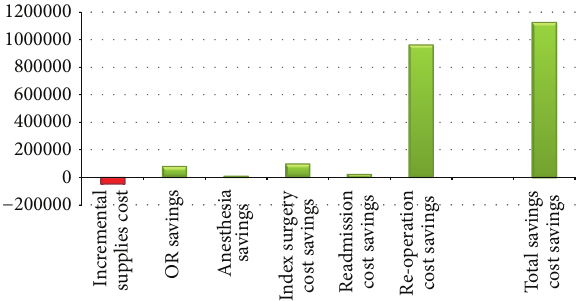
Figure 2: Potential cost savings using mechanical